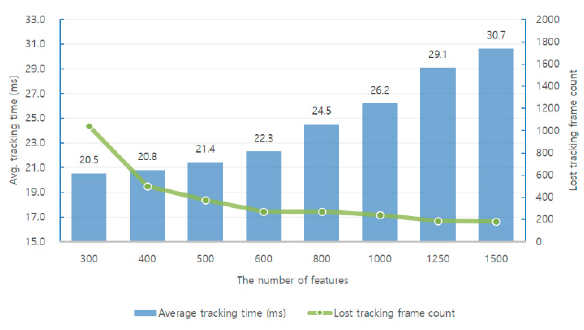
Figure 11. Average tracking time and the number of lost tracking frames versus the number of features used in the monocular ORB-SLAM when running the EuRoC datasets.